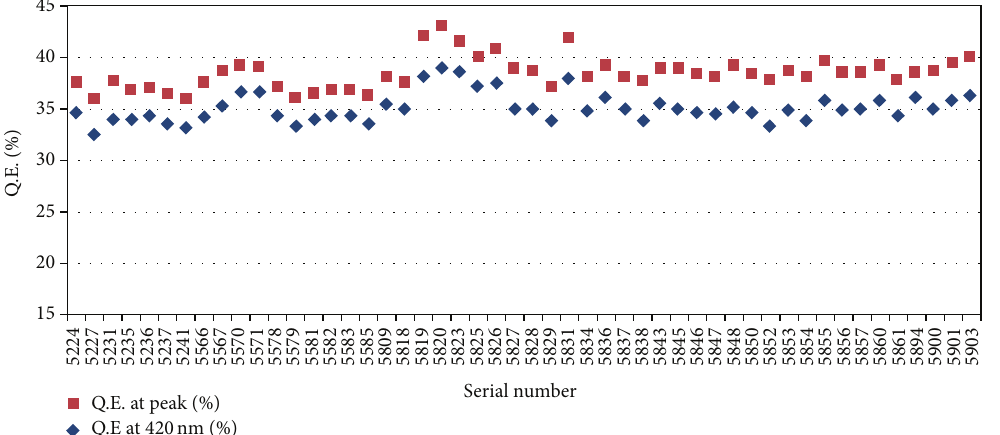
Figure 10: Q.E. at peak and at 420 nm of each one of the 50 high Q.E. PMTs, installed in DAMA/LIBRA-phase2. The averages (RMS) are 38.5% (1.6%) and 35.1% (1.4%), respectively; the RMS show that the Q.E. spread in the PMTs production is well